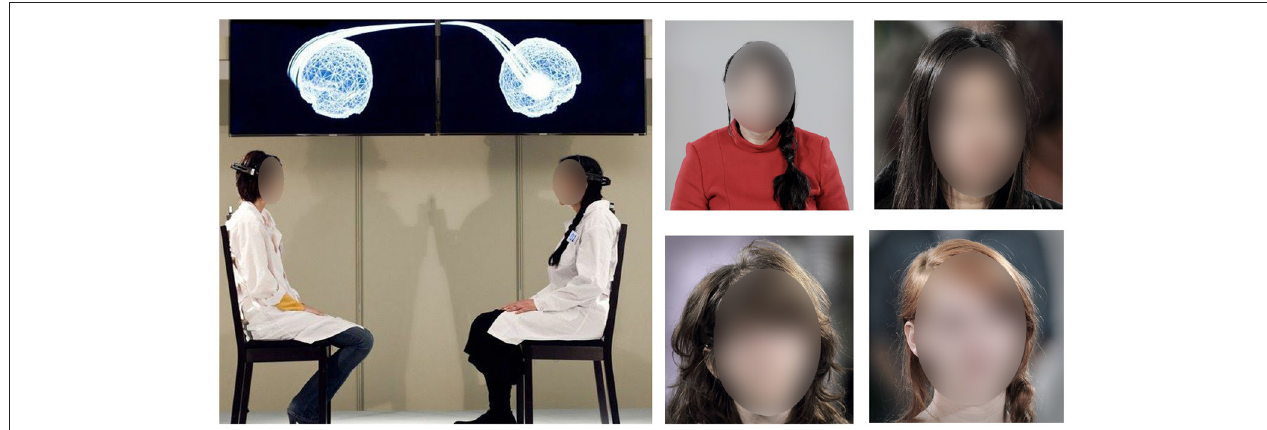
FIGURE 2 | Measuring the magic of mutual gaze & the artist is present. Left: Measuring the magic of mutual gaze at the garage museum for contemporary art, Moscow in 2011. Photograph by Maxim Lubimov © Garage center for contemporary culture. Video: www.youtube.com/watch?v = Ut9oPo8sLJw&t = 73s Right: Marina Abramovi´c, the artist is present, performance, 3 months, the museum of modern art, New York, NY (2010), photography by Marco Anelli. Courtesy of the Marina Abramovi´c Archives.